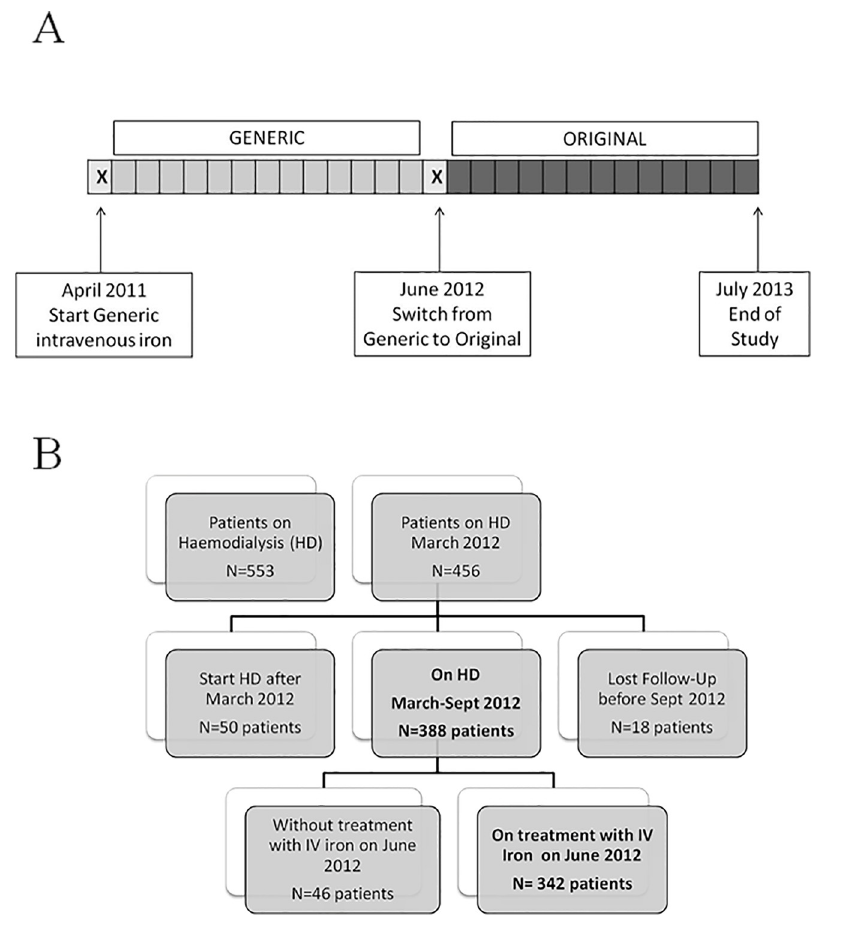
Fig 1. Study design (1A) and algorithm of study population selection